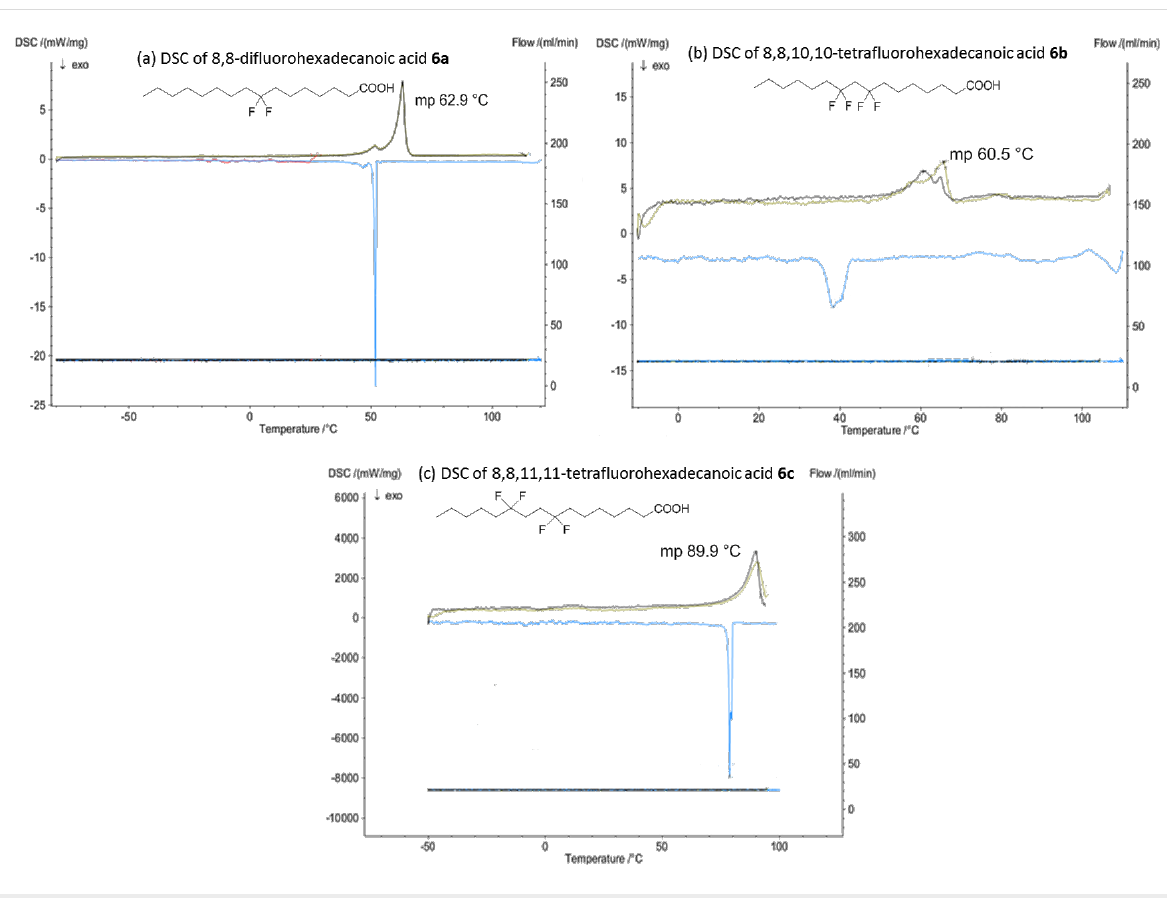
Figure 4: DSC traces for the three palmitic acid analogues 6a–c